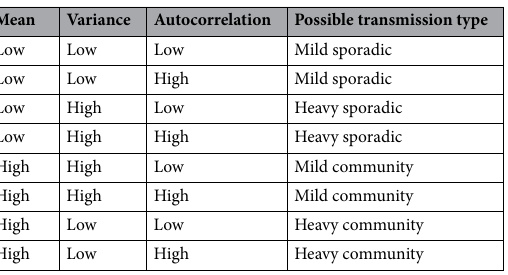
Table 2. Proposed classification of local fractal dimension based on mean, variance, and autocorrelation